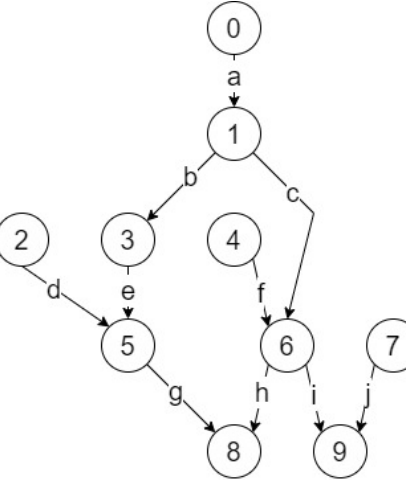
Figure 1. Illustration of an application model.